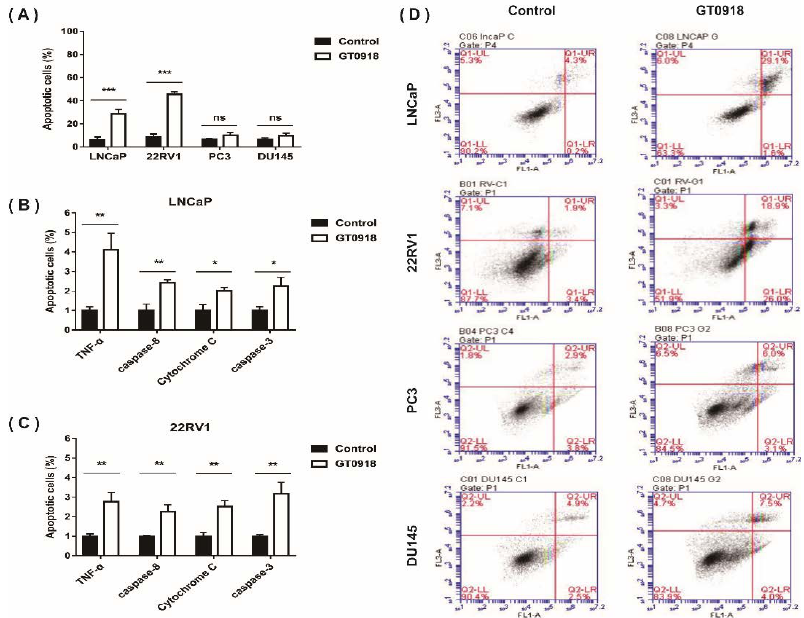
Figure 2. Proxalutamide (GT0918) induces caspase-dependent apoptosis, leading to PCa cell death. ( A , D ) Four PCa cell lines (LNCaP, 22RV1, PC3 and DU145) were exposed to proxalutamide or control vehicle for 48 h. ( A ) Apoptotic cells (%) were measured through Annexin V/PI staining flow cytometry assay. Data represent the mean ± SD of three independent samples, ‘ns’ p > 0.05, *** p < 0.001. ( D ) The typical images of flow cytometry assay in PCa cells. ( B , C ) The mRNA expression of TNF - α , caspase -8, Cytochrome C and caspase -3 after exposure to proxalutamide or control vehicle in LNCaP and 22RV1 cells, respectively. The relative mRNA level was defined as 1.0 (fold) in the vehicle-treated cells. Data were normalized by β -actin mRNA expression and are shown as the mean ± SD ( n = 5), * p < 0.05, ** p < 0.01.